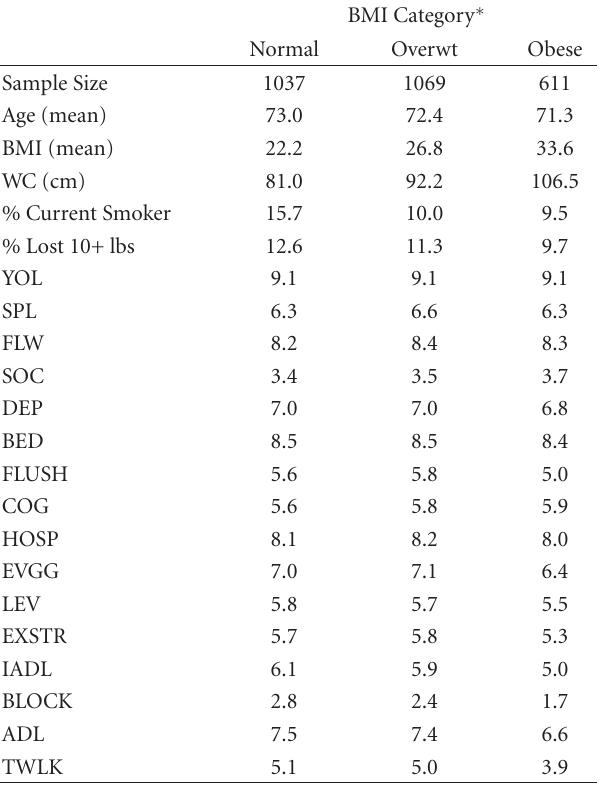
Table 3: Means by BMI category (white women